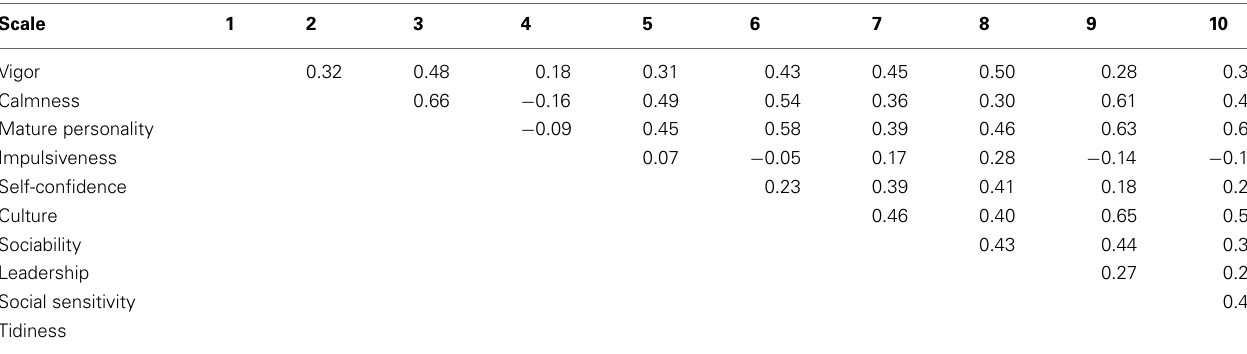
Table 3 | Intercorrelations among the Project Talent Personality Inventory scales.